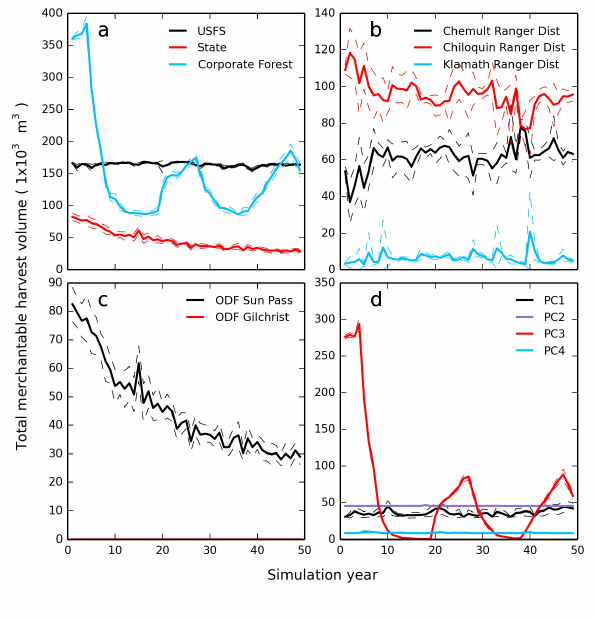
Fig. 8. Change in total merchantable harvest volume between model simulation years 1 and 50, between and within forest ownership categories. Dashed lines indicate upper and lower 95% confidence intervals for 15